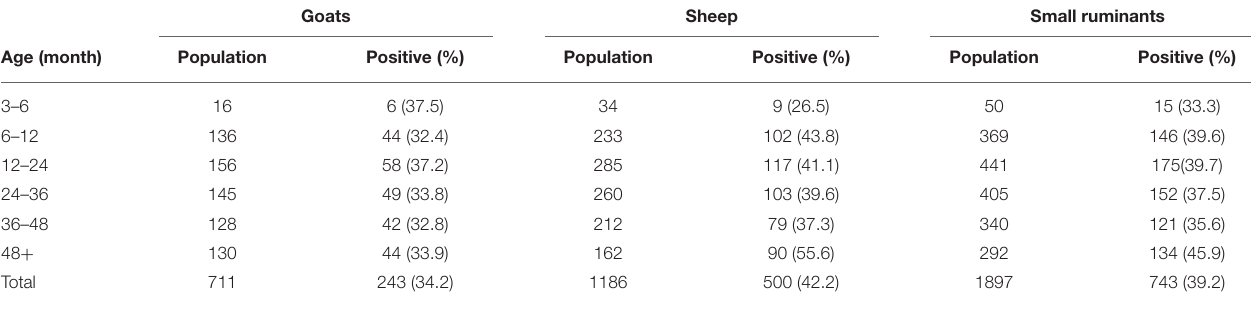
TABLE 2 | Number and percentage (in brackets) of seropositive PPR animals in each age group, by species. Goats Sheep Small